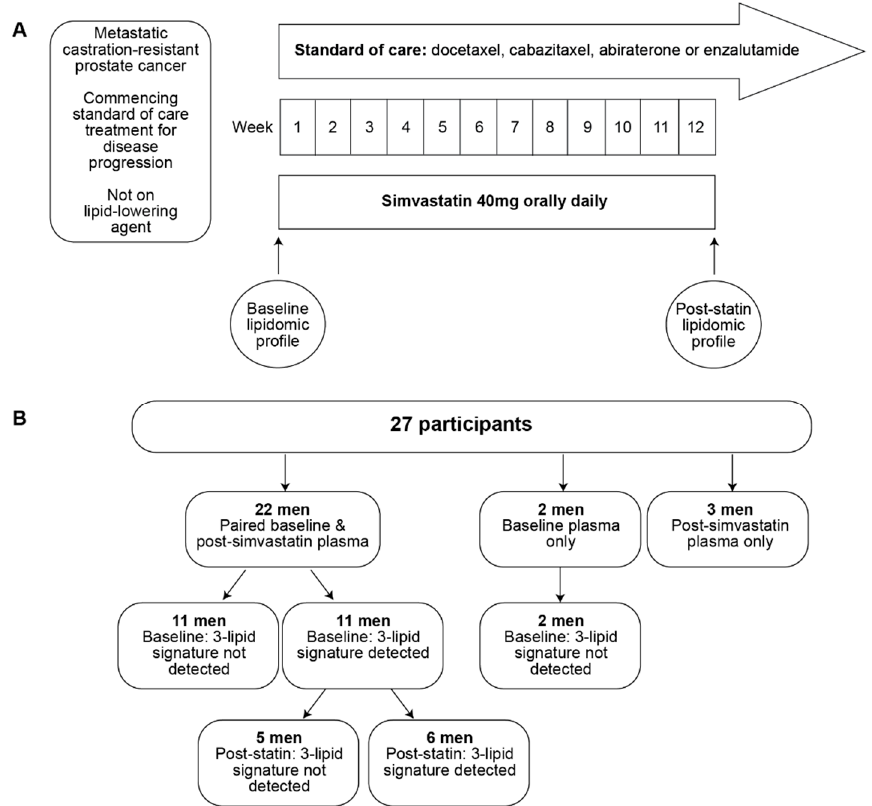
Figure 1. Study schema and participants of the clinical trial: ( A ) Study schema; ( B ) number of participants and their 3-lipid signature status.